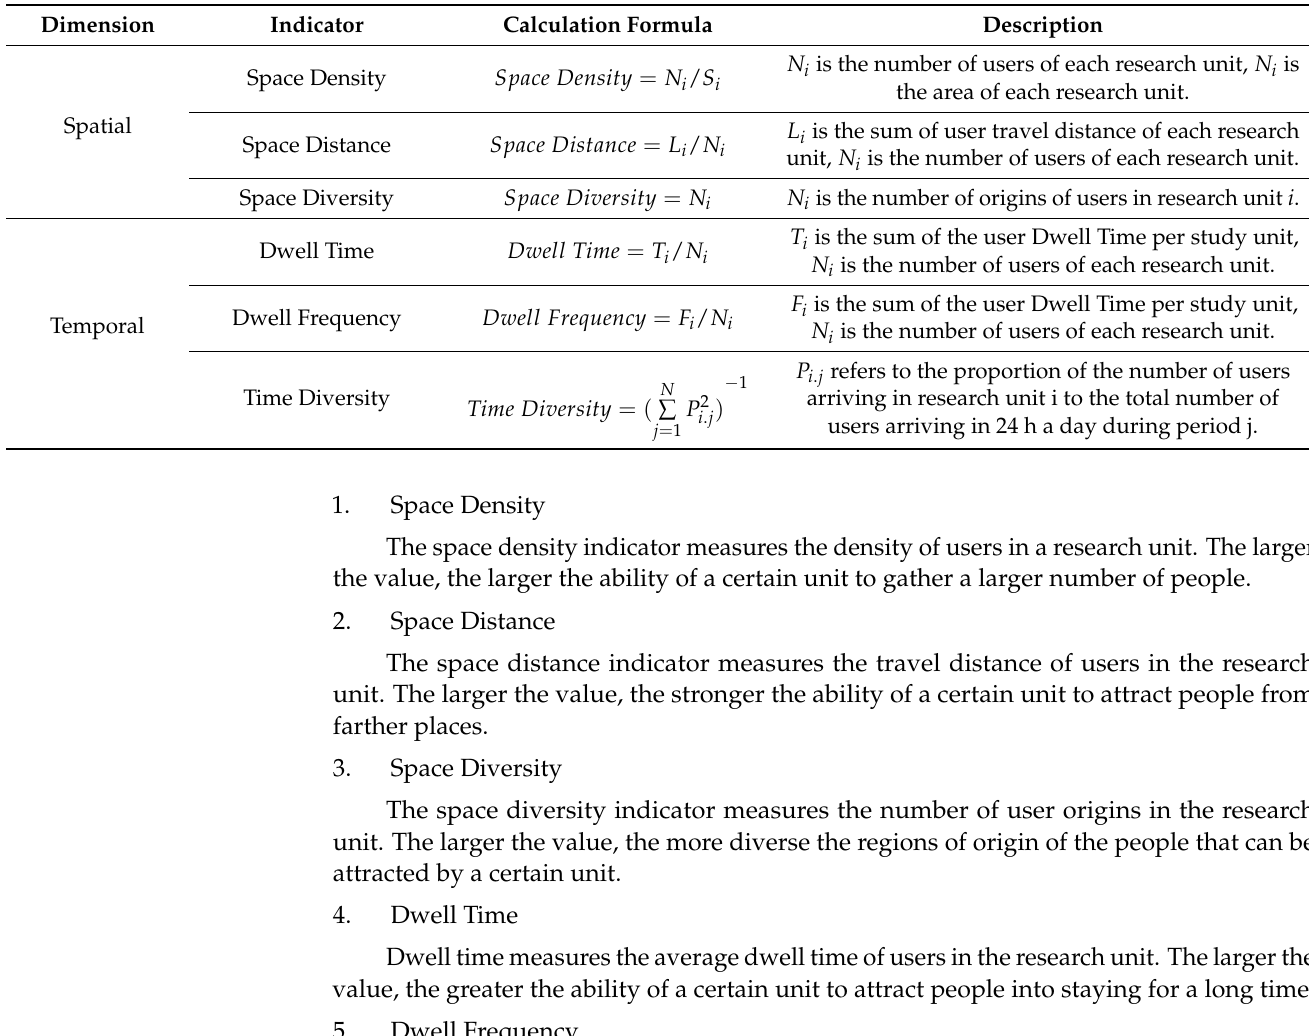
Table 3. The spatiotemporal attractiveness